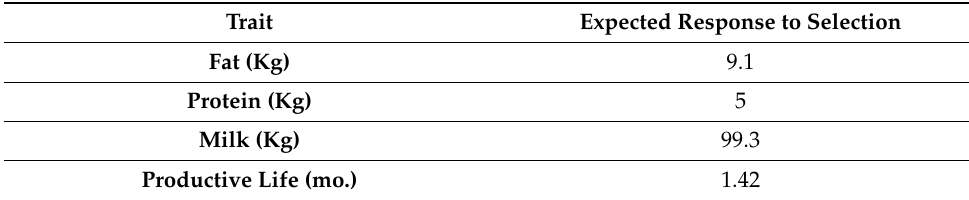
Table A1. Expected response to the selection expressed in units of the underlying trait when the average DWP$ 2022 is increased by 1SD. Adapted from Zoetis data on file, Technical Bulletin CLR-00428, Table